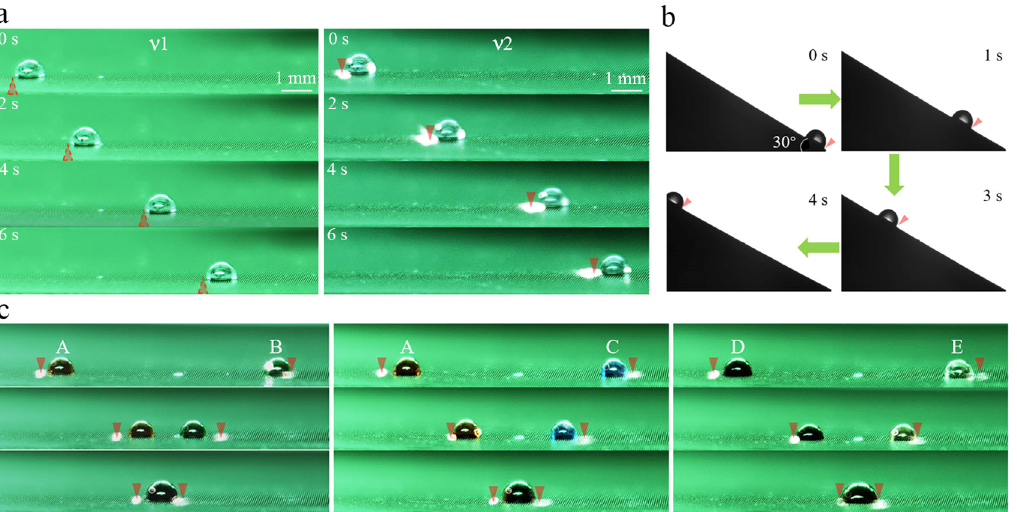
Figure 7. Applications of HD-PTSS. ( a ) Bottom-side manipulation for eye-safe devices. ( b ) Droplet transportation from low to high. ( c ) Biological reagent manipulation for fusion.